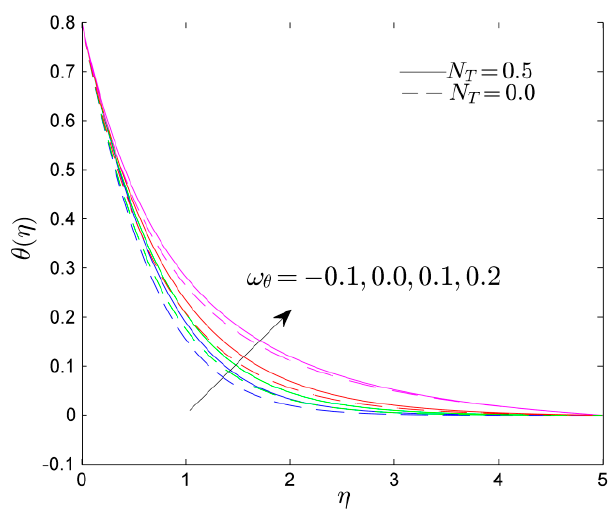
Figure 14. Effect of thermal relaxation time parameter (𝜔 (cid:3087) ) on 𝜃(𝜂) .